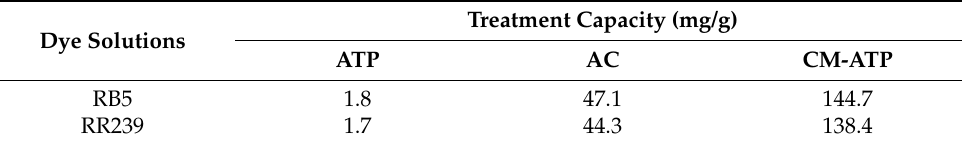
Table 5. Sample treatment capacities for dye solutions in column adsorption